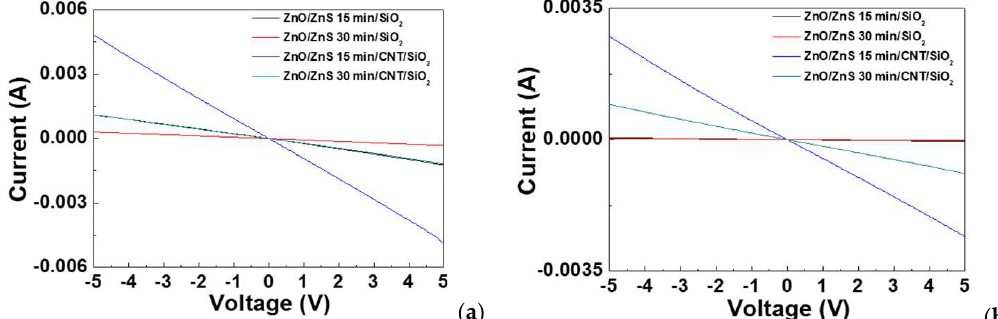
Figure 7. Current–voltage curve (I–V curve) for the ZnO / ZnS 15 min / SiO 2 -based light sensor, ZnO / ZnS 30 min / SiO 2 -based light sensor, ZnO / ZnS 15 min / CNT / SiO 2 -based light sensor, and ZnO / ZnS 30 min / CNT / SiO 2 -based light sensor ( a ) in the dark and ( b ) under the light. Table 2. Comparison of dark current and light current at a fixed voltage of − 2 V toward the samples of ZnO / ZnS 15 min, ZnO / ZnS 30 min, ZnO / ZnS 15 min / CNTs, and ZnO / ZnS 30 min / CNTs. Voltage Dark Current Light Current